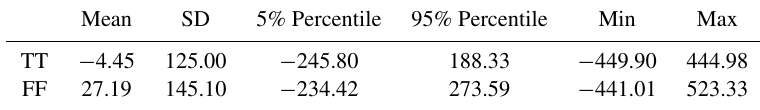
Table 6. Statistical quantities of the distributions of (cid:49) SIS shown in Fig. 9a.